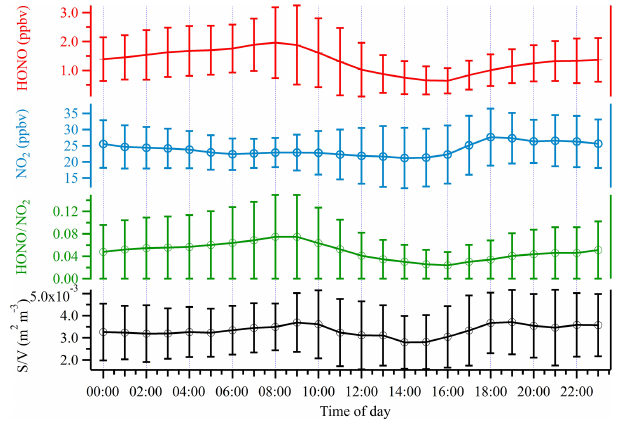
Figure 3. Average diurnal profiles of HONO, NO 2 , the HONO / NO 2 ratio and S/V . Error bars represent the standard devi- ations in hourly bins.